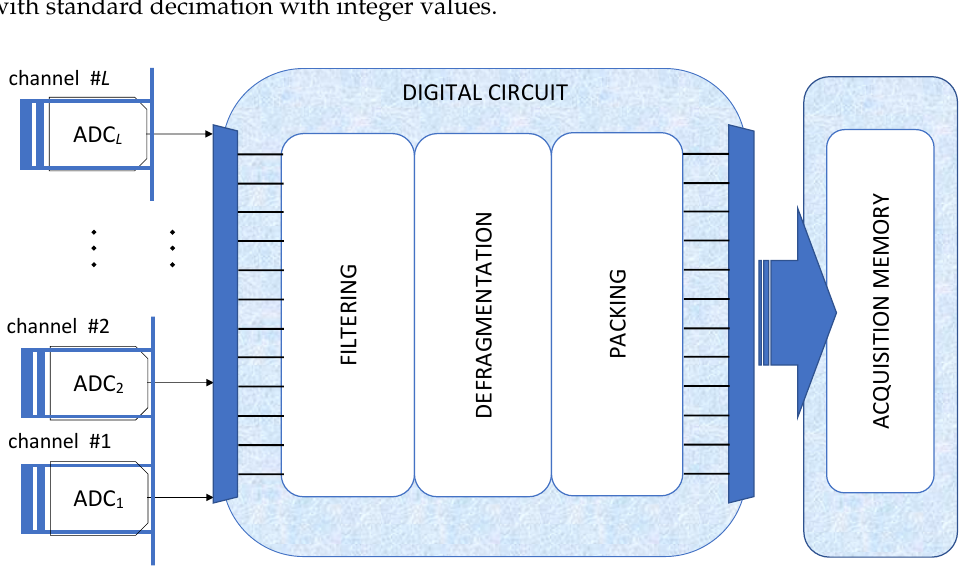
Figure 2. Schematics of the system that enables fine sample rate selection in